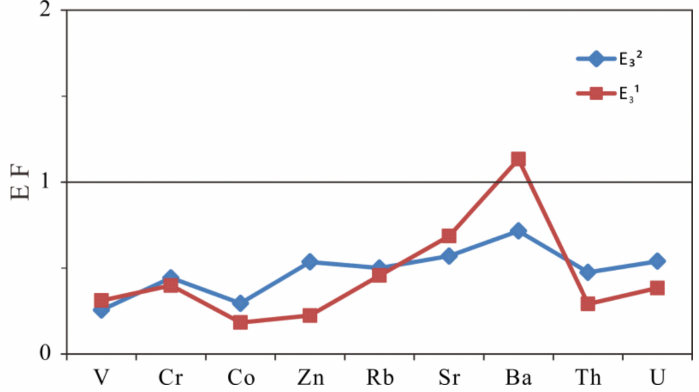
Figure 6. Comparison of trace elements between samples and the average shale. EF (enrichment factor) = Csediment / Cstandardrock. E 3 2 = UpperXiaganchaigouFormation. E 3 1 =